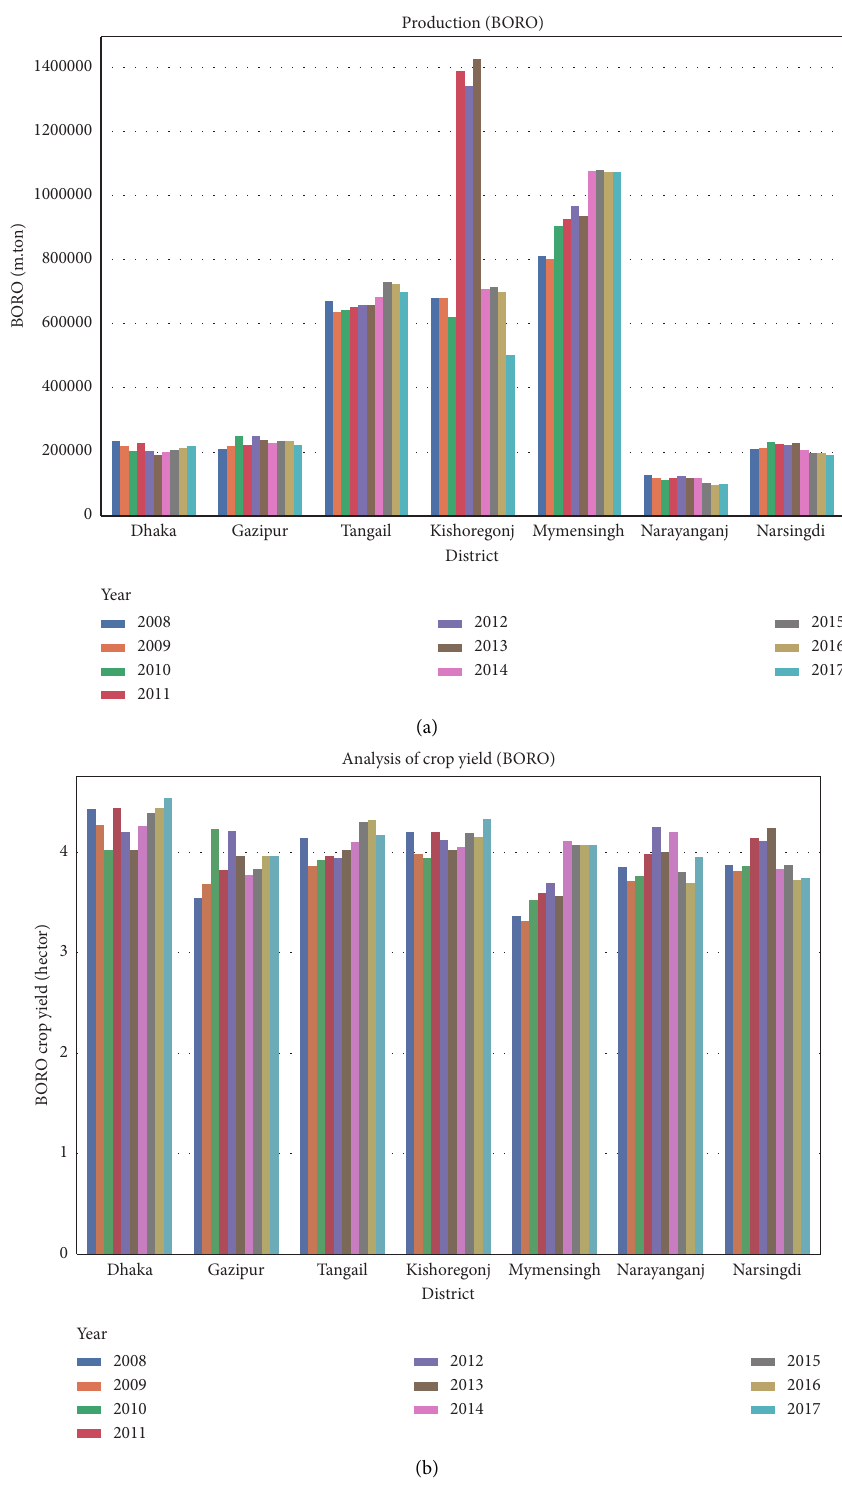
Figure 7: Data analysis of Boro rice. (a) Crop production for Boro rice. (b) Crop yield for Boro